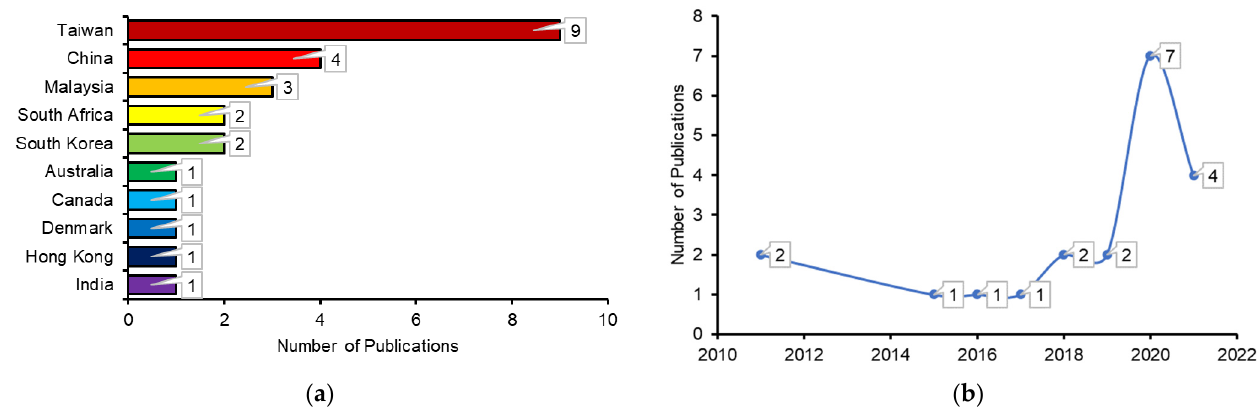
Figure 1. Number of publications in the co-torrefaction process ( a ) country-wise for the whole period and ( b ) year-wise retrieved from the Scopus database (2 October 2022).